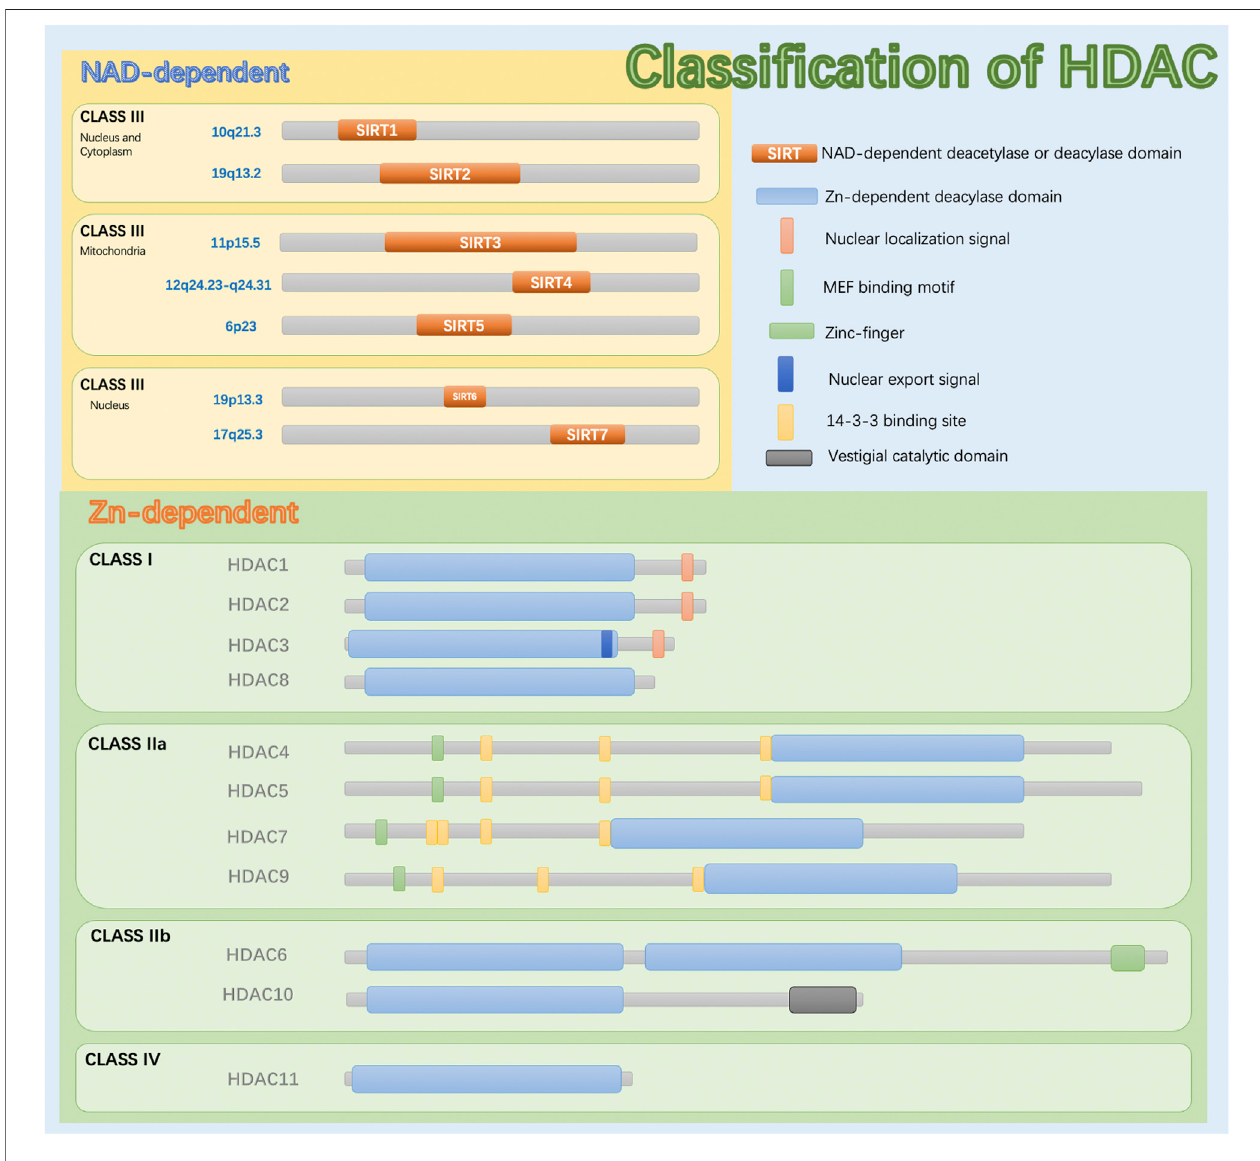
FIGURE 1 | The classi fi cation and molecular structure of